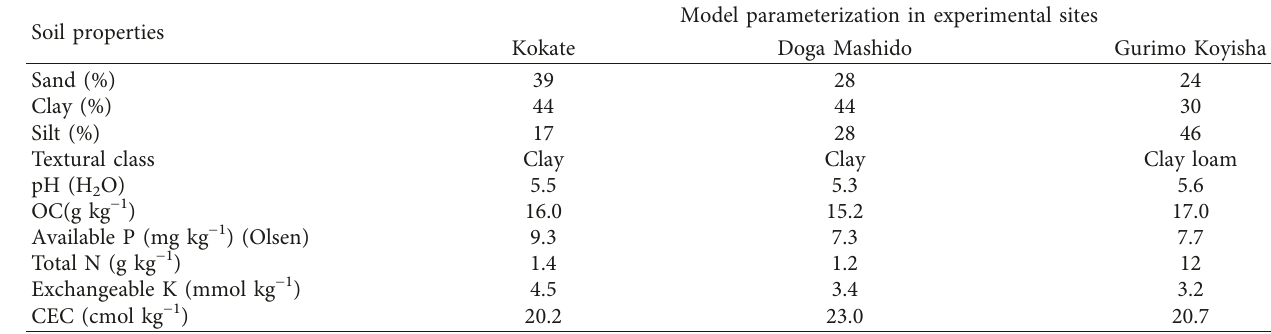
Table 2: Physicochemical properties of experiment sites.